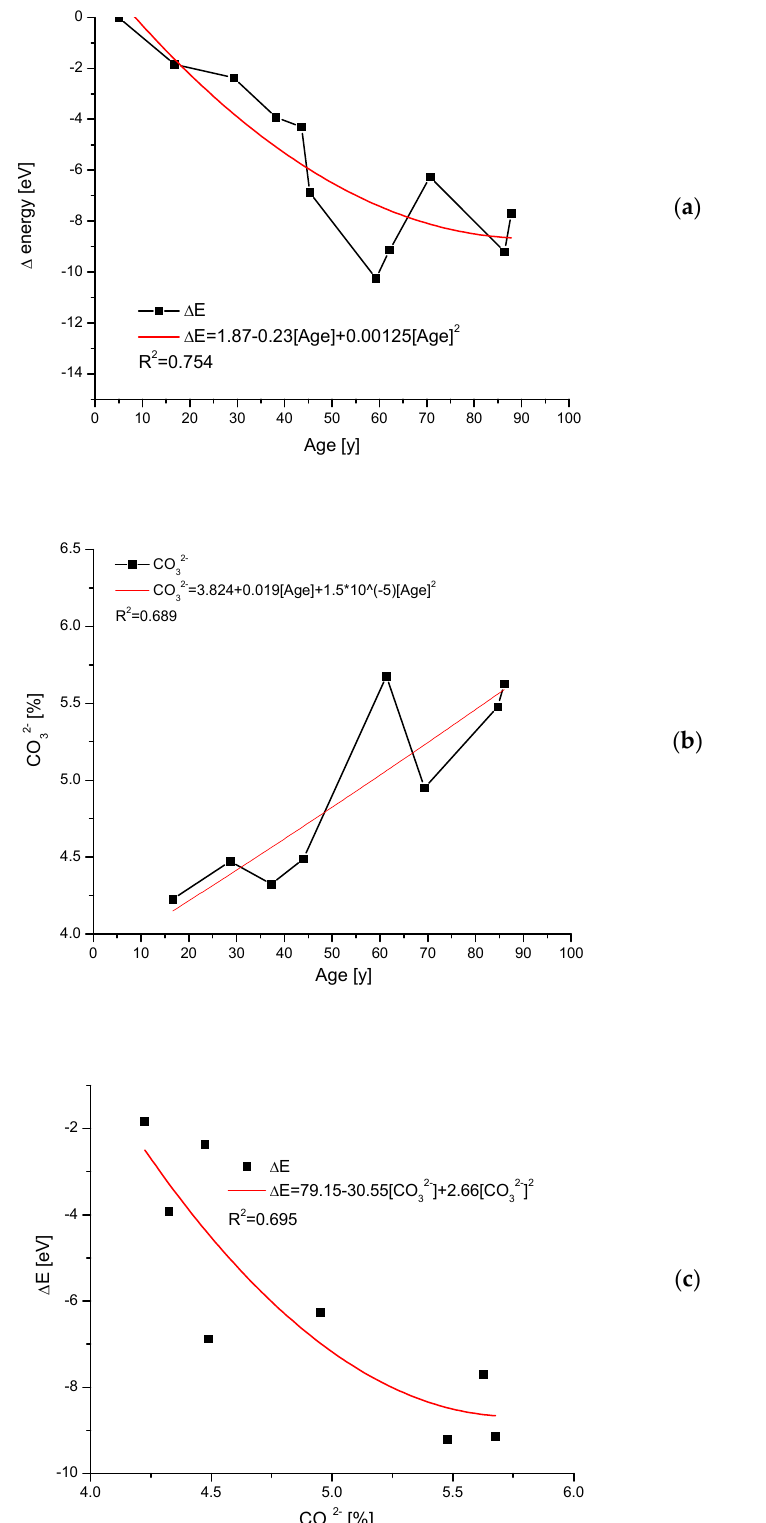
Figure 5. ( a ) The drop of energy change during the aging of teeth; ( b ) variability of carbonate amounts coupled with the aging; ( c ) intercoupling of energy changes with contents of carbonates. Basic data from position